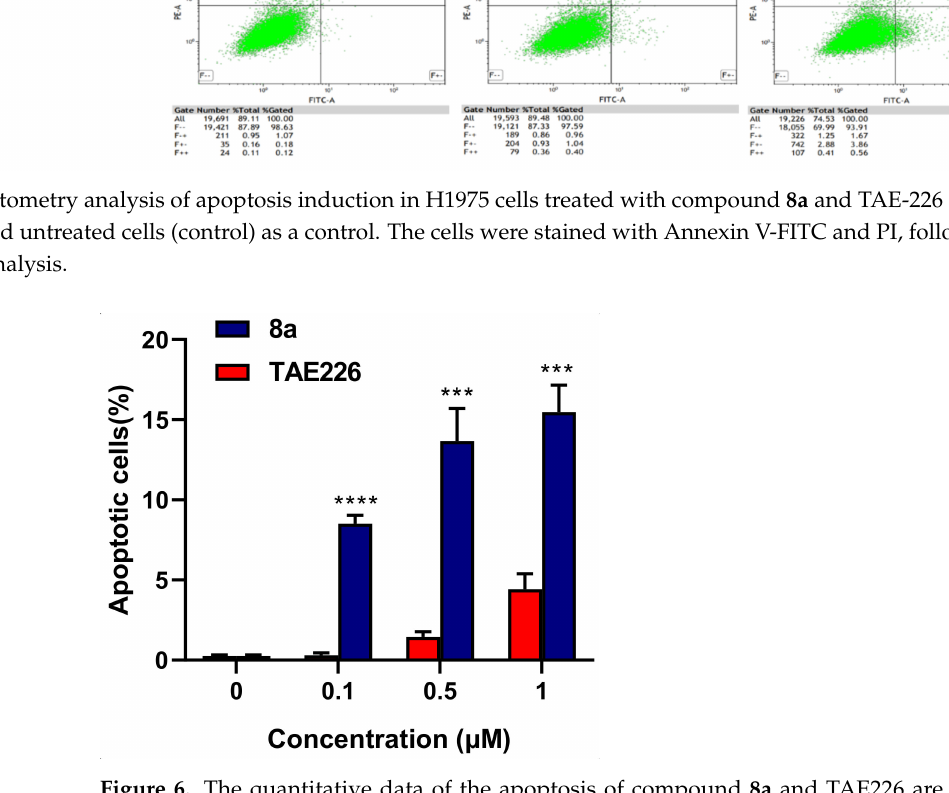
Figure 6. The quantitative data of the apoptosis of compound 8a and TAE226 are expressed as the mean ± SD of the percentages of apoptotic cells from three independent experiments. Key: (***) p < 0.001, (****) p < 0.0001 vs. TAE226